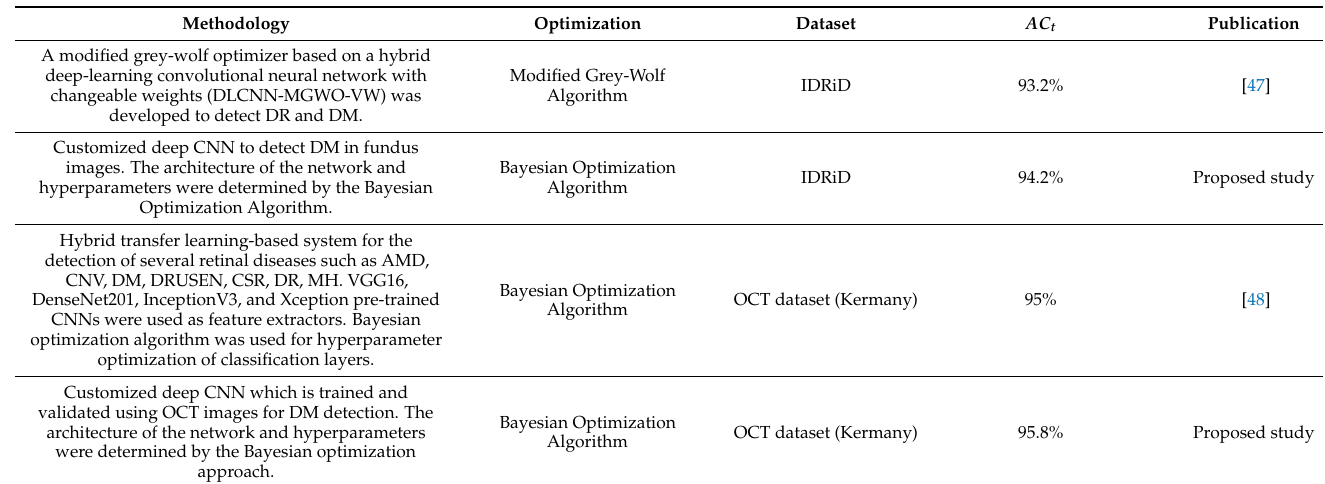
Table 13. The proposed Bayesian-based optimal CNN results compared with the state-of the-art model-based